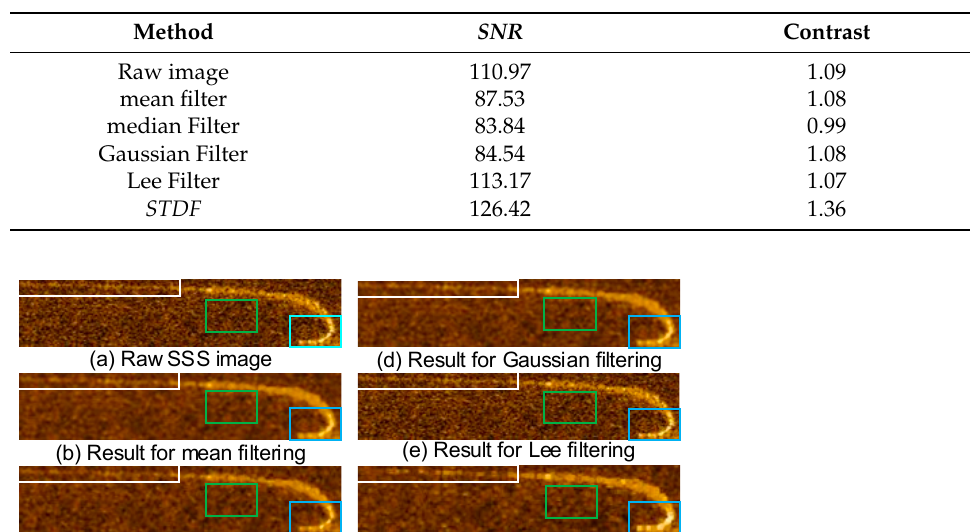
Table 2. Comparison of the SNR and contrast of several filtering methods.